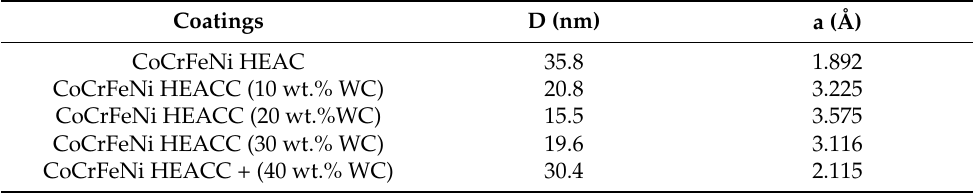
Figure 3. XRD patterns: ( a ) mixed powders; ( b ) CoCrFeNi HEACC.